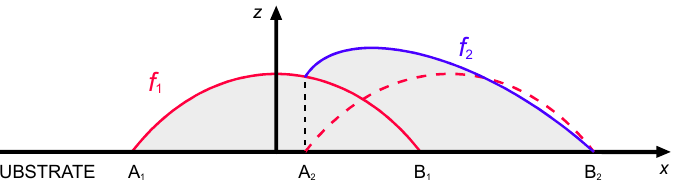
Figure 4. Shape functions f i for the deposited metal in the cross-section, overlapping deposition.